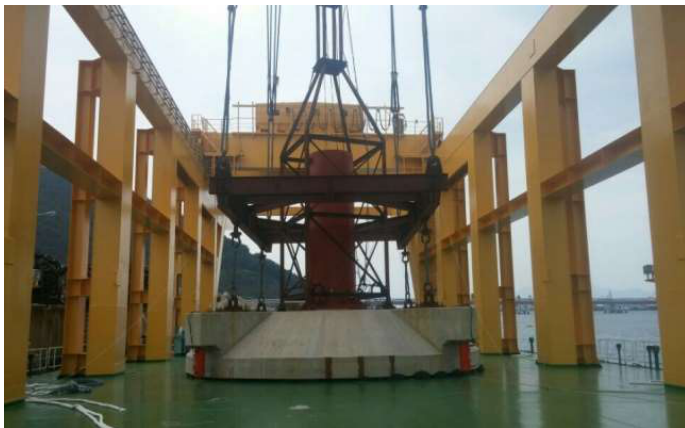
Figure 8. The caisson-type gravity-based support structure.